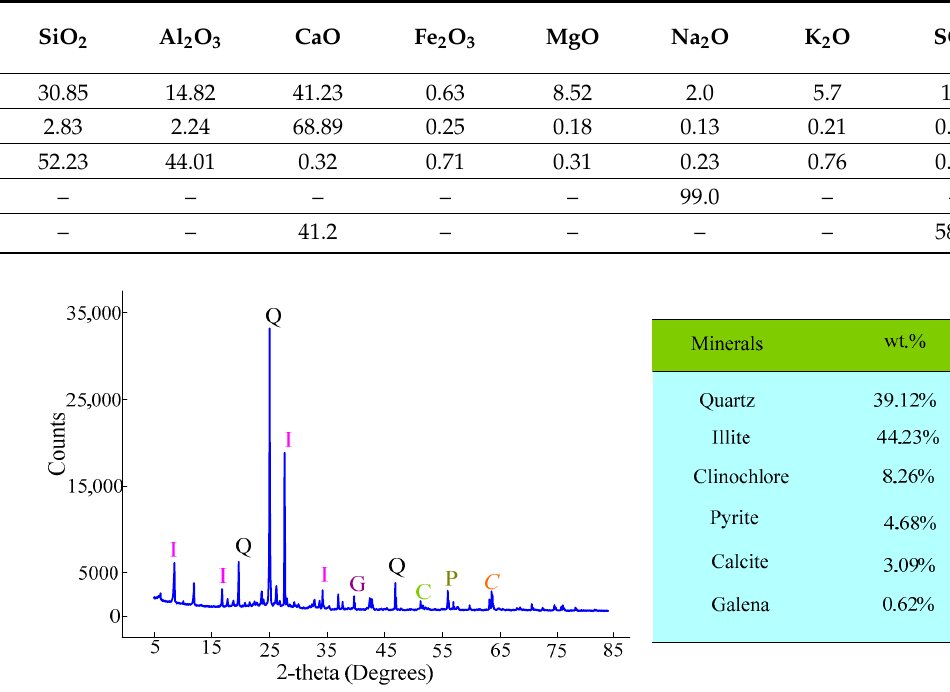
Figure 2. XRD pattern and mineralogical compositions of gold mine tailings.